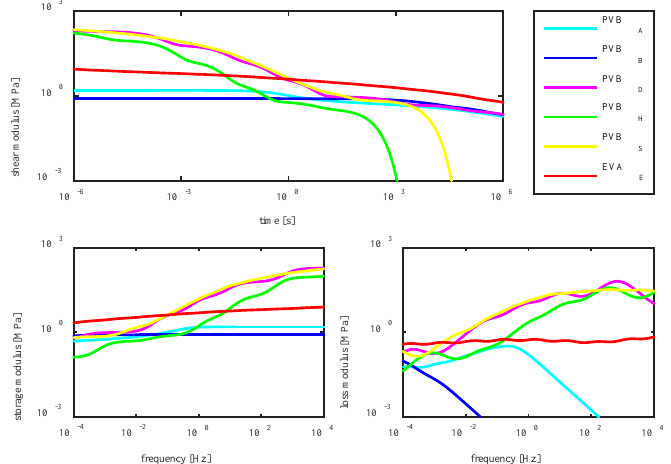
Fig. 1 Relaxation shear moduli and storage and loss shear moduli in frequency domain for PVB and EVA foils from Table 1 at